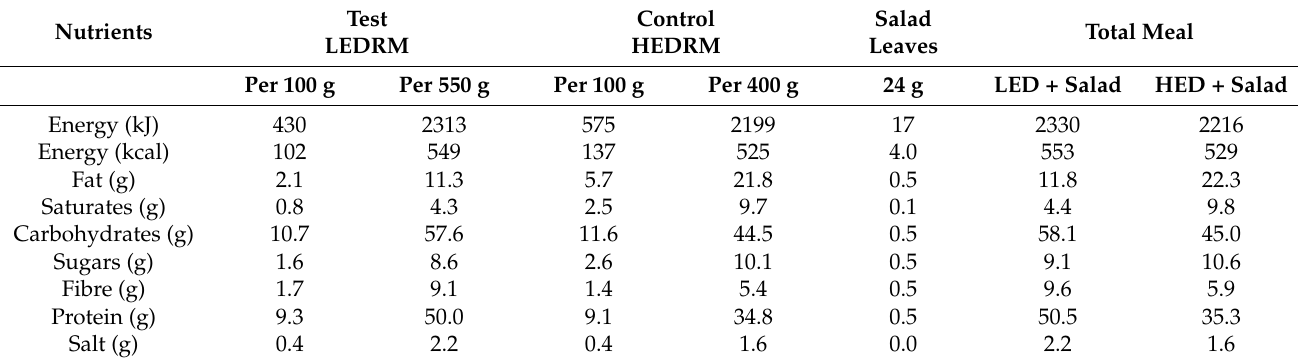
Table 1. Nutritional values for test low-energy-dense ready meal (LEDRM) and control high-energy-dense ready meal (HEDRM) per 100 g and per portion (550 g for LEDRM and 400 g for HEDRM) as well as the salad leaves that accompanied the meals and the total for each test